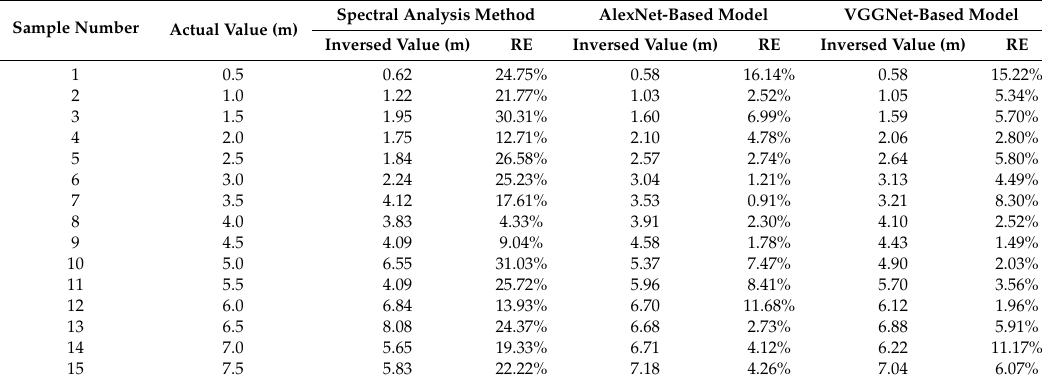
Table 3. Inversion results of significant wave height ( H S ).